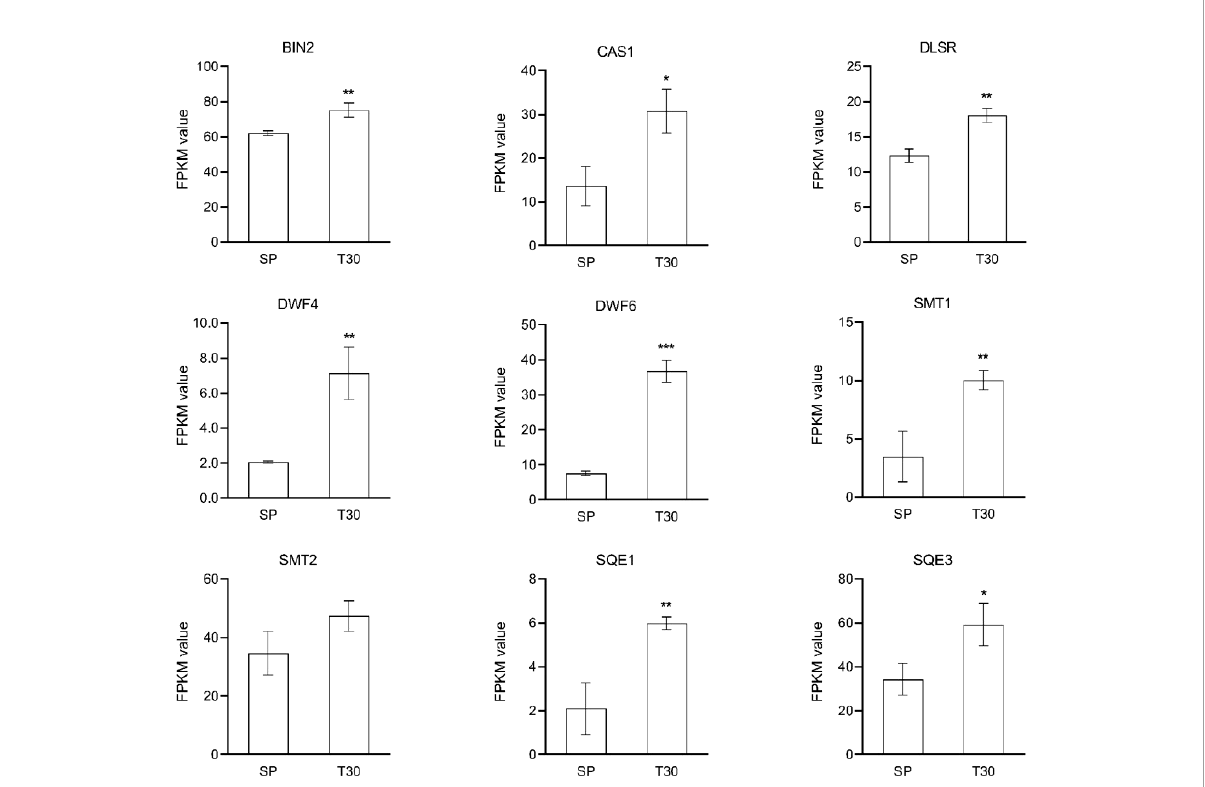
FIGURE 10 Expression analysis of BR related genes. The expression level of genes was represented by FPKM value. Data are represented as the mean ± S.D. from 3 independent biological replicates. Means with the " * " were signi fi cantly different among samples according to one-way ANOVA test ("*", p< 0.05; "**", p< 0.01; "***", p< 0.001). BIN, brassinosteroid-insensitive; CAS1, cycloartenol synthase 1; DLSR, delta14-sterol reductase; SMT1, sterol methyltransferase 1; SMT2, sterol methyltransferase 2; SQE1, squalene epoxidase1; SQE3, squalene epoxidase